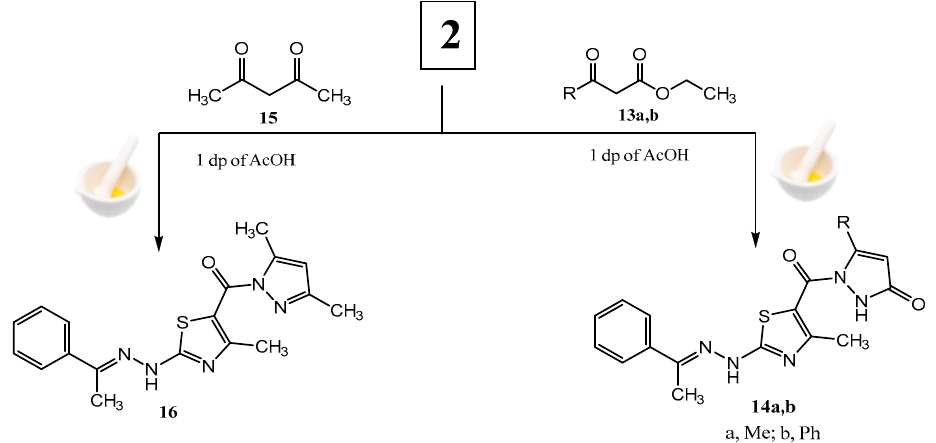
C Figure 1. ( A ) Structure of the standard inhibitor Remedesivir, ( B ) 2D pose and ( C ) surface map of the interaction of Remedisvir into the active site of SARS-Cov-2 RdRp (PDB: 7bv2). All hybrids have been already docked into the active site of RdRp, and the binding free energy ( Δ G) from the main docked poses was shown in Table 1. Figures 2–5 depict the most favorable poses of the compounds investigated. Most of these examined materi- als have potential activity against the SARS-CoV-2 RdRp enzyme as the energy scores ranging from − 4.52 to − 6.63, while the Δ G is ranging from − 0.6 to − 3.2 Kcal/mol in com- parison to the value from –2.5 to − 5.1 Kcal/mol for the Remdesivir reference drug. Table 1. Energy scores and types of interactions observed for the investigated compounds and the reference Remedisvir in the active sites of RdRp (PDB: 7bv2).